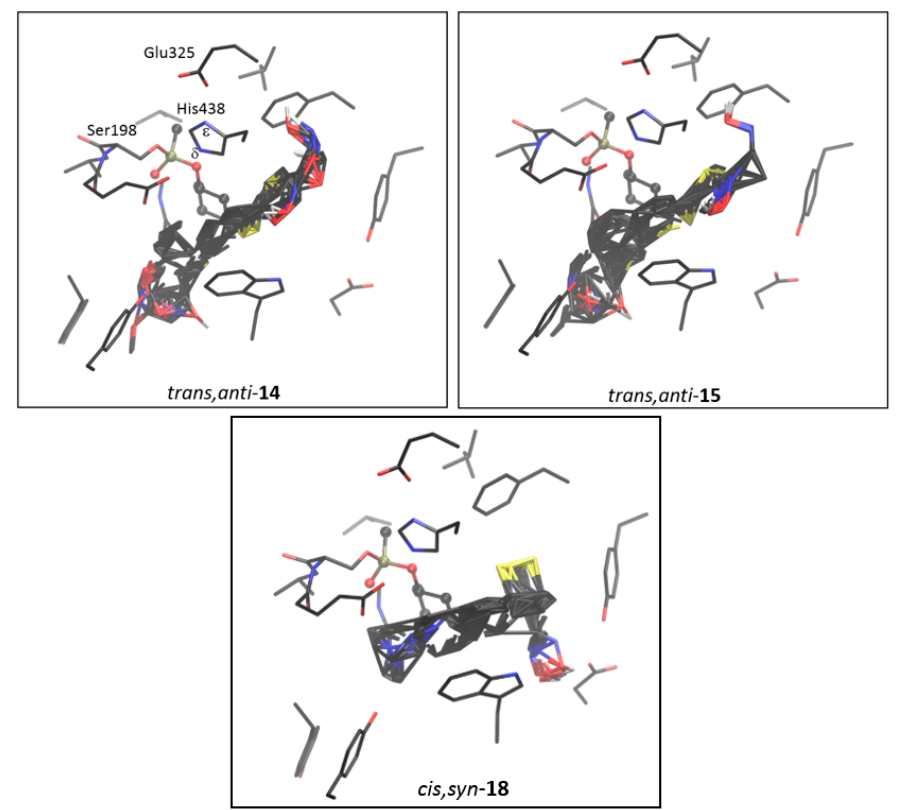
Figure 5. Structures of the active site of cyclosarin-inhibited BChE with docked thienostilbene ox- imes: trans,anti - 14 , trans,anti - 15 , and cis,syn - 18 . Cyclosarin (presented using the ball and stick model) is covalently bound to Ser198.